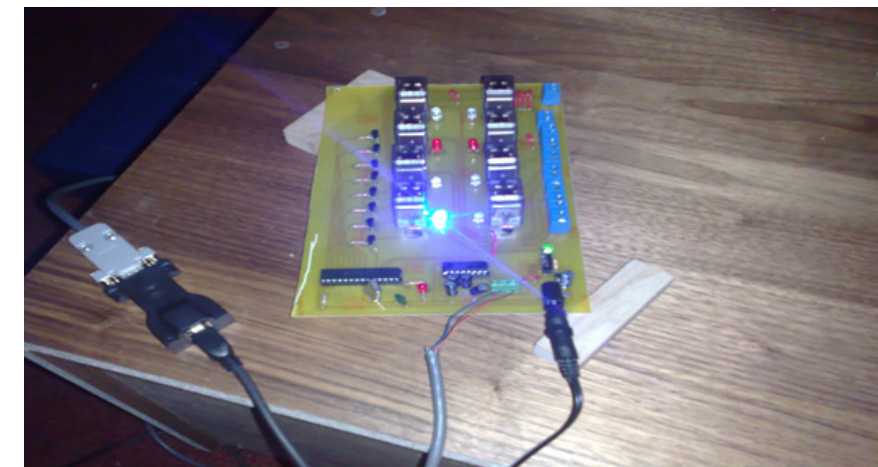
Fig. 10. DC power and green LED